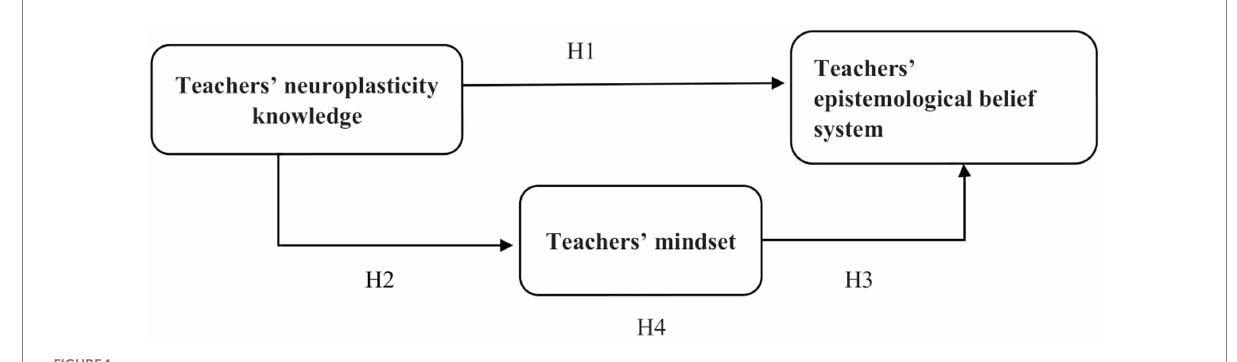
FIGURE 1 The conceptual model of relationships between the main variables of the